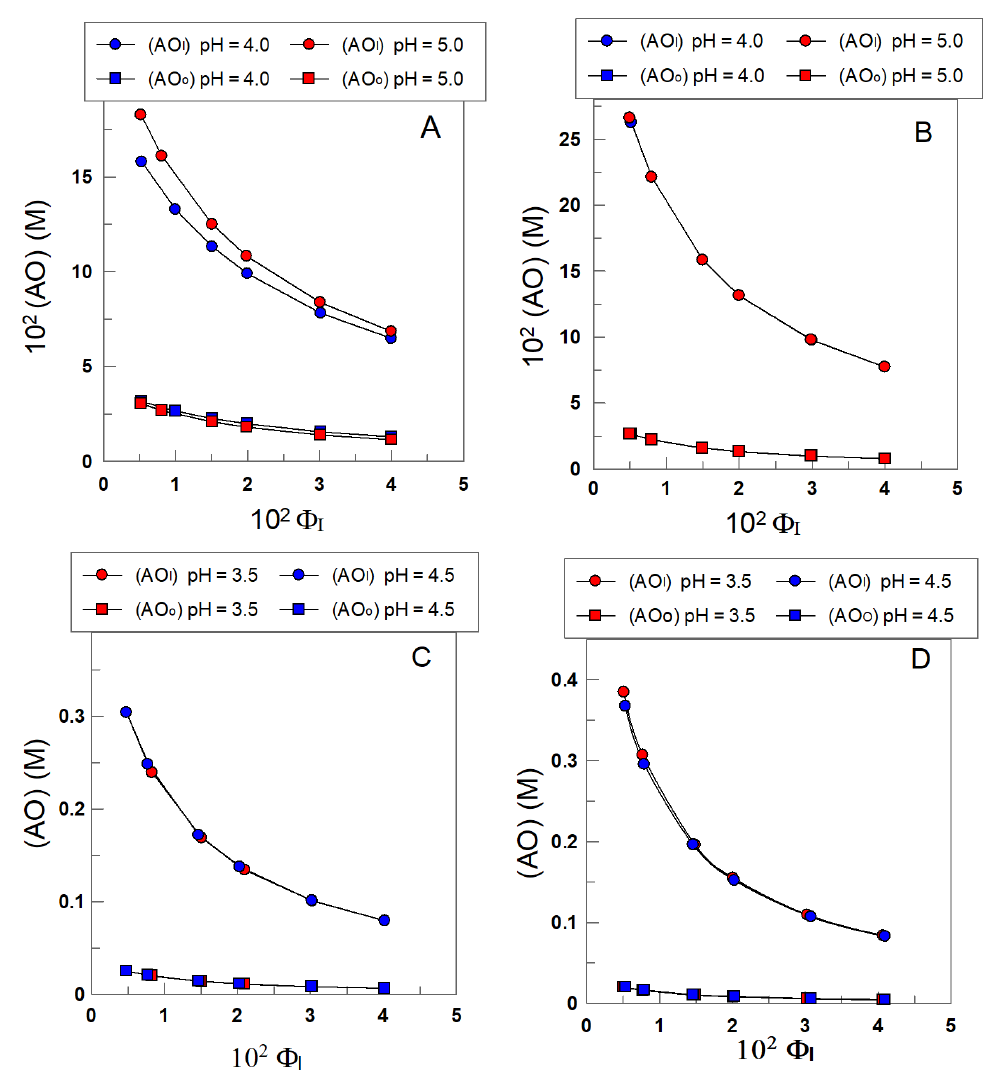
Figure 6. Variations of effective concentrations of α -TOC ( A – C ) and δ -TOC ( B , D ) with the surfactant volume fraction in the oil (O) and interfacial (I) regions of 1:9 ( v : v ) olive ( A , B ) and soybean ( C , D ) o/w emulsions. [TOC T ] = 4 × 10 − 3 M.